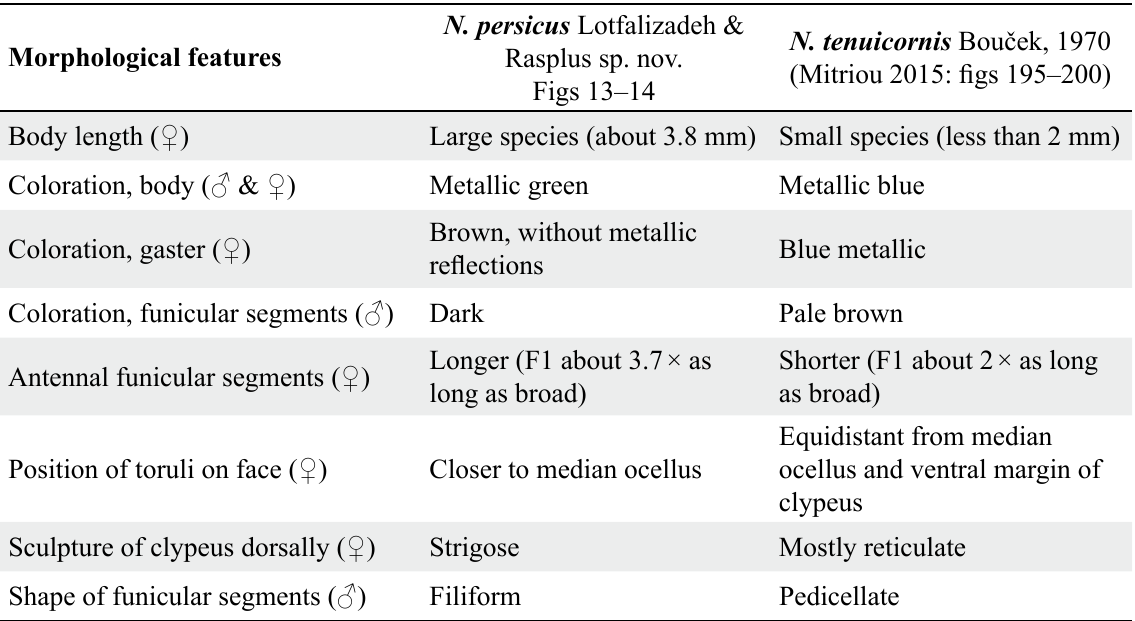
Table 3. Features distinguishing both sexes of Norbanus persicus Lotfalizadeh & Rasplus sp. nov. from N. tenuicornis Bouček,